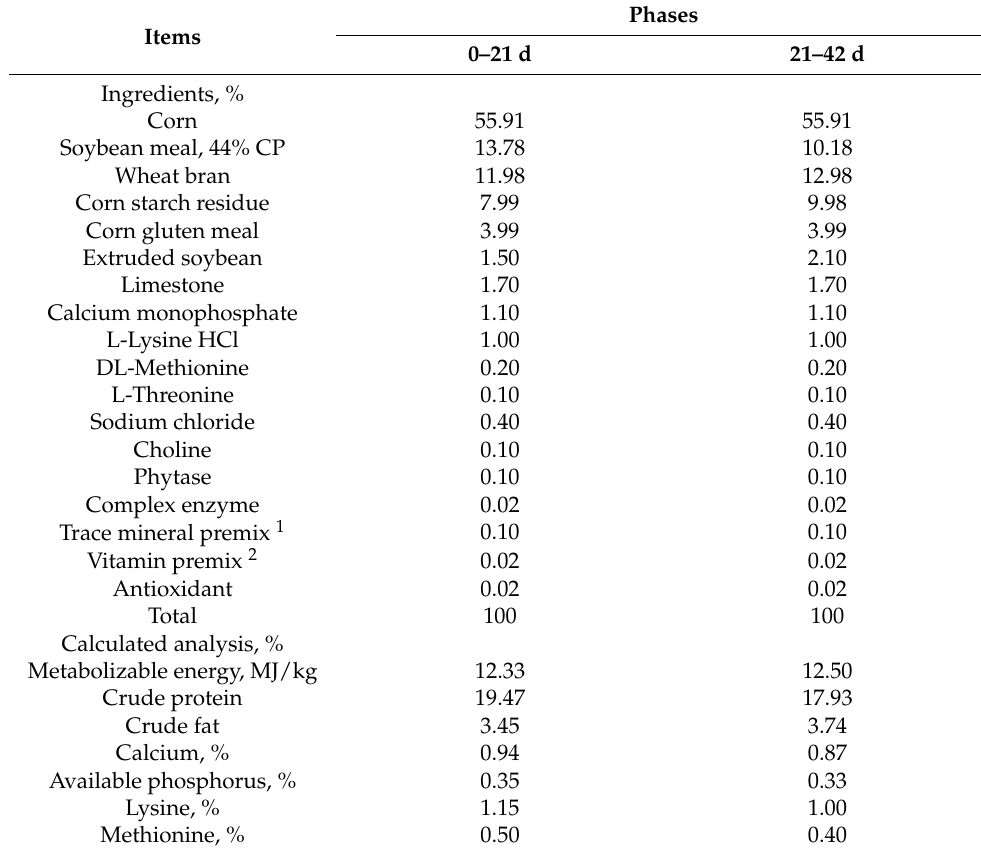
Table 1. Ingredients composition and nutrient levels of basal diets (as-fed